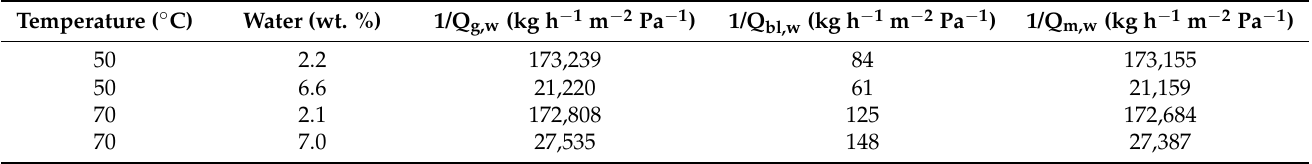
Table 1. Global and individual resistances to the mass